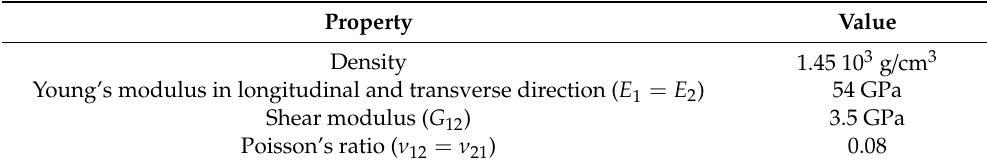
Table 1. Material properties.